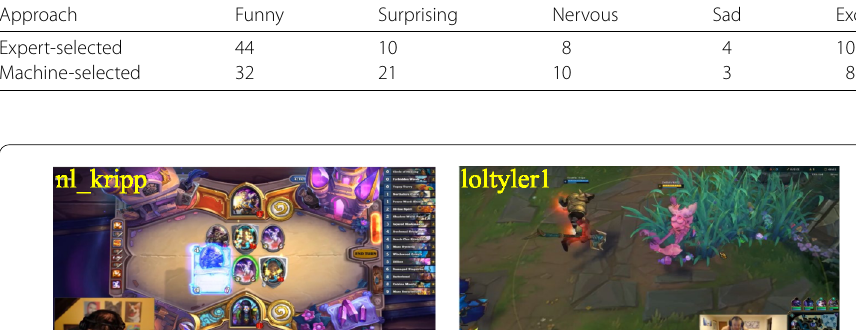
Table 8 Number of video moments where each emote cluster appears in the audience chat. Note that an audience chat can include none or multiple emote clusters Approach